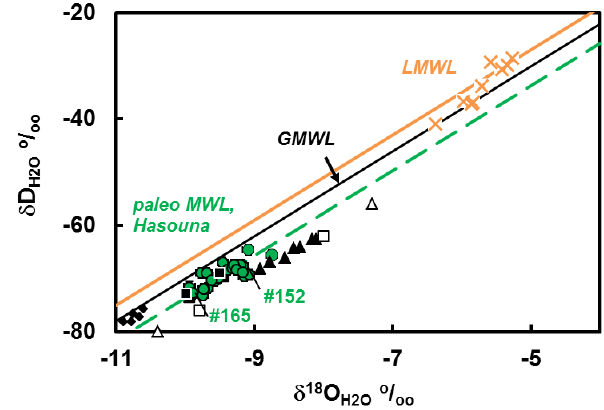
water recharged by modern precipitation close to Tripoli (own precipitation close to Tripoli (own data). GMWL: Global Meteoric Water Line (  D = 8  18 O + 10; Craig, 1961). LMWL: Local Meteoric Water Line for Sfax metereological concen- 3 in 3